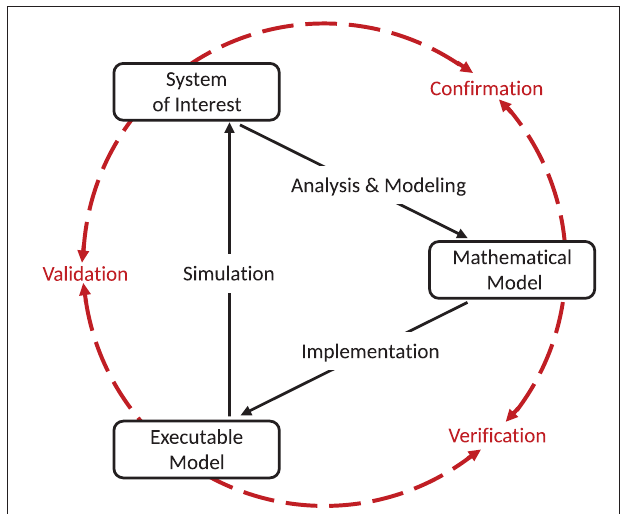
FIGURE 1 | Schematic view of the model simulation environment introduced by Schlesinger (1979). The figure and terminology is adapted from Thacker et al. (2004) , and defines the relationships between the system of interest, mathematical model, and executable model as confirmation, verification, and validation. Modeling and simulation activities are indicated by black solid arrows, whereas assessment activities are indicated by red dashed arrows. Figure amended from Trensch et al.